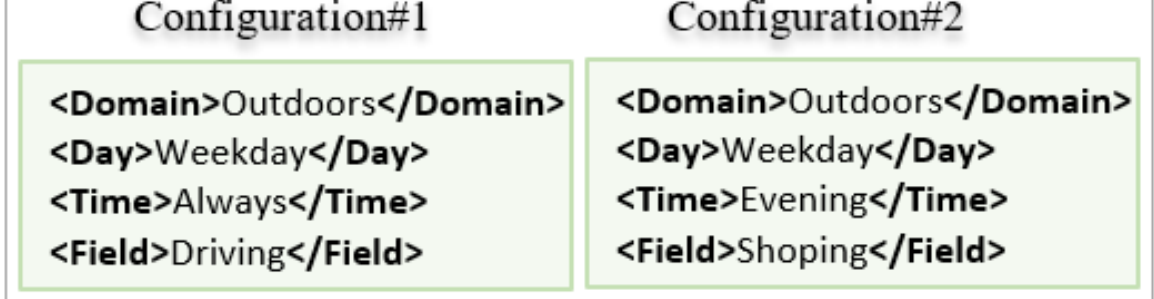
Figure 10. Explicit preferences for the second scenario.